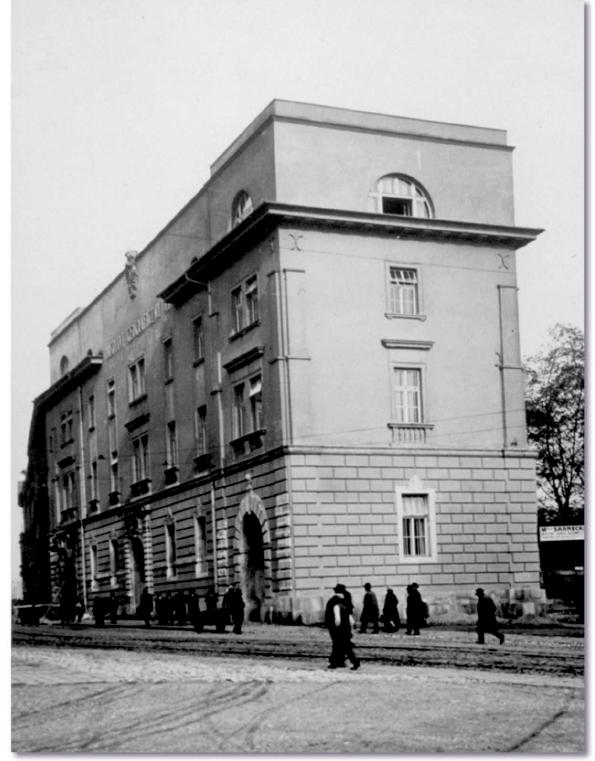
Figure 1. The building of the Jagiellonian University School of Tourism in 1936, Krakow (source: the archives of Antoni Jack- owski).